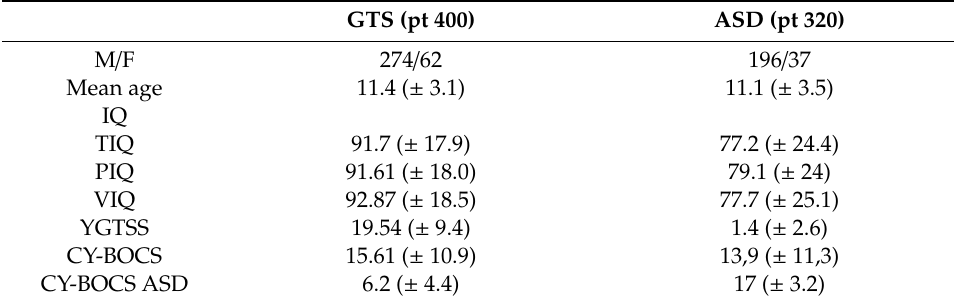
Table 1. Demographic and clinical features.